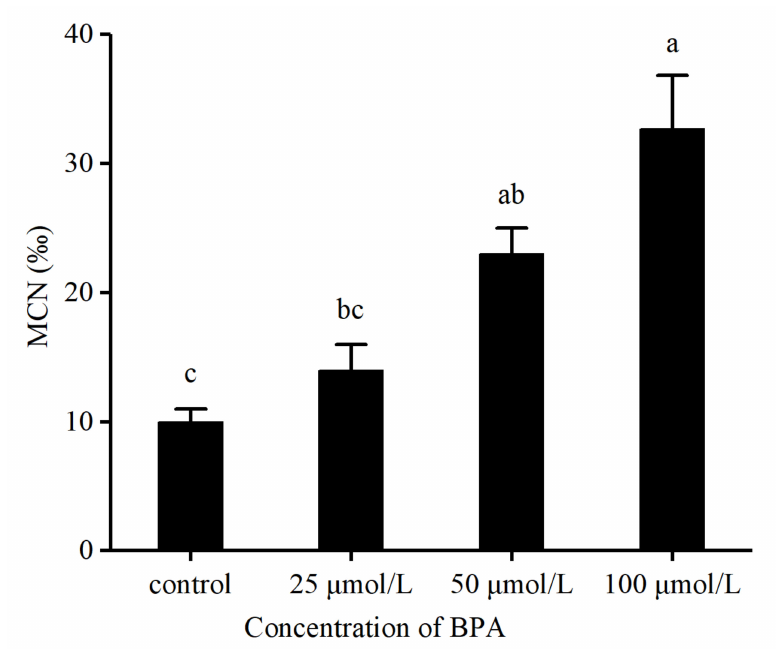
Figure 1. BPA exposure causes later micronuclei in blood cells. The tadpoles were exposed to BPA for 6 h before refreshing the water, and the micronucleus rate was measured again after 24 h. Different letters above the bars indicate significant differences among groups (a > b > c, p < 0.05). n =